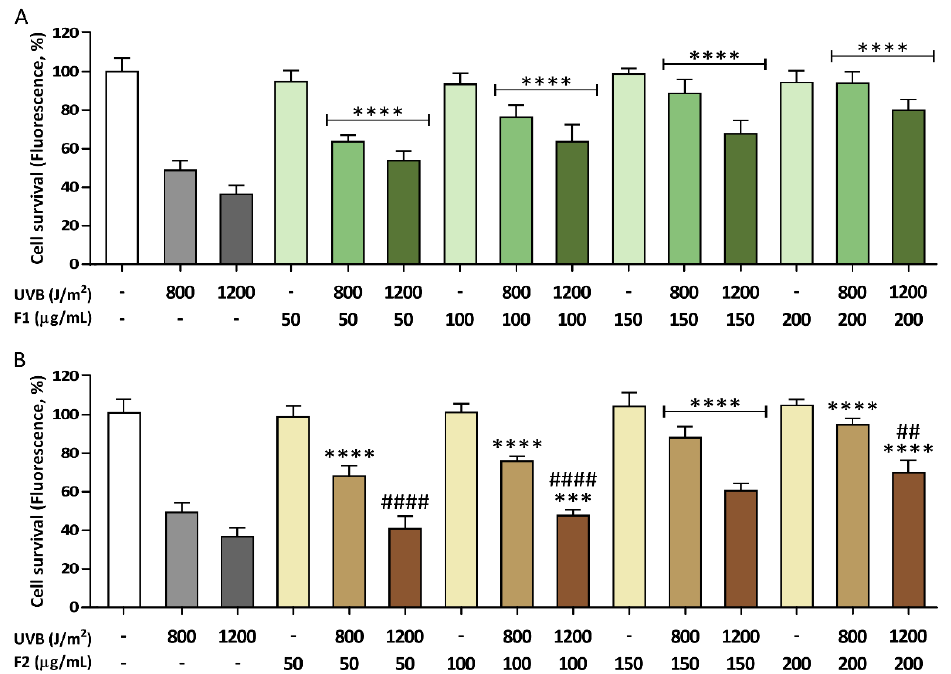
Figure 3. Photoprotective effects of formulations F1 ( A ) and F2 ( B ) on human keratinocytes during UVB exposure (800 or 1200 J/m 2 ). The viability of HaCaT cells was determined using Hoechst 33342 nuclei staining after incubation of cells for 24 h postirradiation. No cytotoxic effects were observed in treated nonirradiated cells. The data are expressed as the mean ± SD. *** ( p < 0.001) or **** ( p < 0.0001) indicate significant differences at the same UVB dose with nontreated cells, while ## ( p < 0.01) or #### ( p < 0.0001) indicate significant differences between cells treated with the other formulation at the same concentration with the same UVB irradiation dose.